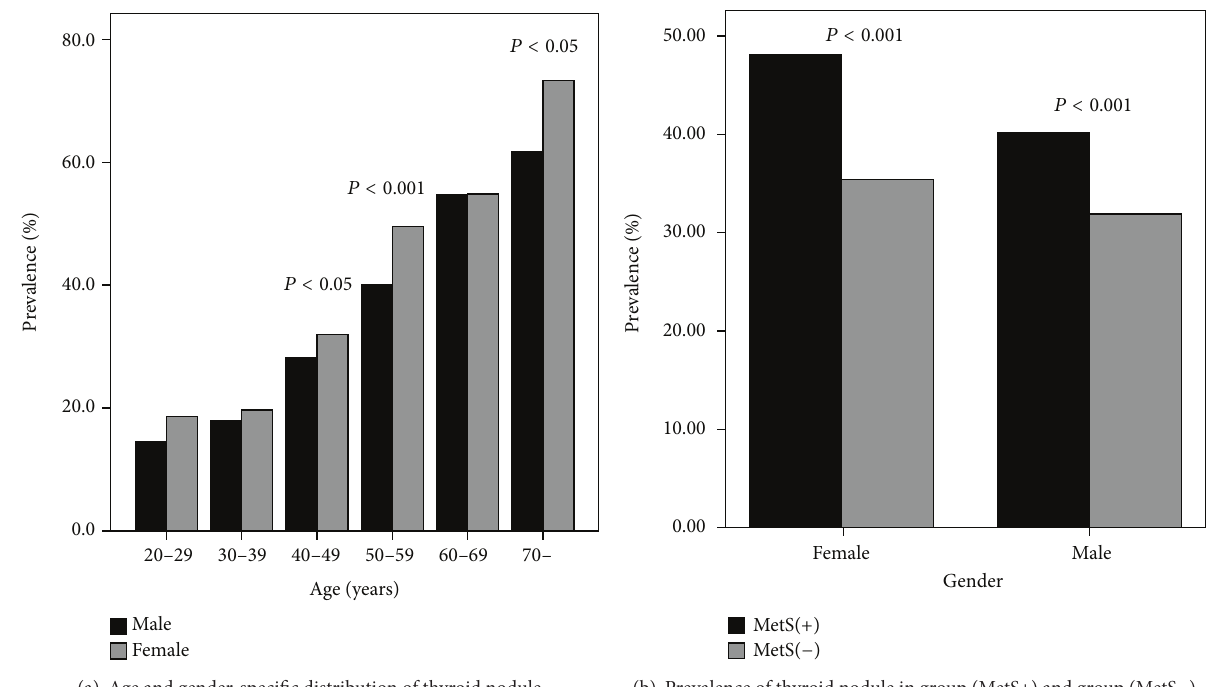
Figure 1: Prevalence of thyroid nodules. (a) The prevalence of thyroid nodules for women was significantly higher than for men in the 40 to 49 age range, 50 to 59 age range, and the age above 70 ( 𝜒 2 = 8.904 , 𝑃 = 0.003 ; 𝜒 2 = 29.044 , 𝑃 < 0.001 ; 𝜒 2 = 4.631 , 𝑃 = 0.031 , respectively). The prevalence of thyroid nodules increased along with increasing age (trend 𝜒 2 test: 𝜒 2 = 515.22 for men, 𝑃 < 0.001 ; 𝜒 2 = 921.56 for women, 𝑃 < 0.001 ). (b) The prevalence of thyroid nodule in the MetS (+) group was higher than in the MetS ( − ) group for both sexes together (41.71% (1157/2774) versus 33.23% (3572/10748), 𝜒 2 = 69.63 , 𝑃 < 0.001 ) and for men and women separately (female: 48.15% (260/540) versus 35.43% (1437/4056), 𝜒 2 = 33.10 , 𝑃 < 0.001 ; male: 40.15% (897/2234) versus 31.90% (2135/6692), 𝜒 2 = 50.80 , 𝑃 < 0.001